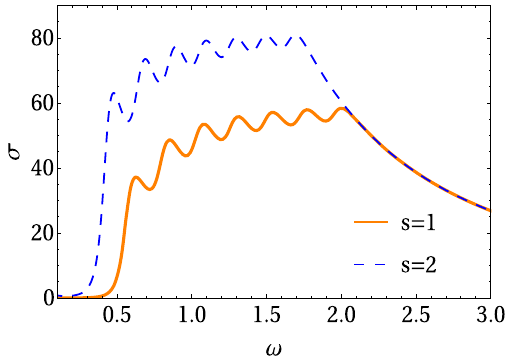
Fig. 21 Total absorption cross section( σ ) vs ω for q = 0 . 4 and (cid:2) = 0 .